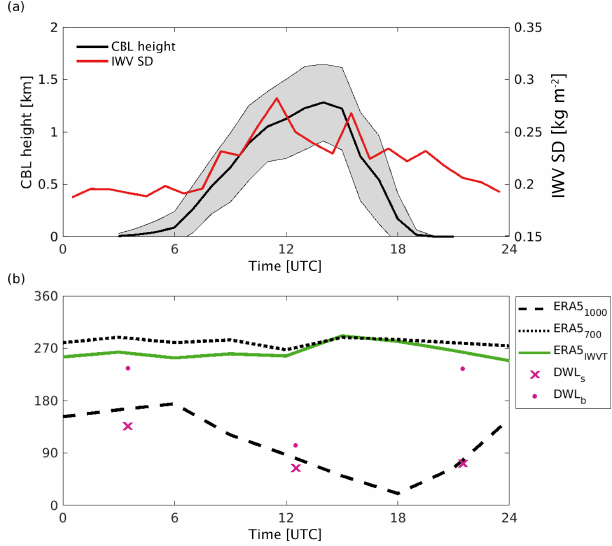
Figure 2. (a) Hourly averaged convective boundary-layer (CBL) height (with standard deviation in shadings) from the Doppler lidar boundary-layer classification at the MWR scan times. The zenith IWV standard deviation (SD) is determined within 1h around the scans. (b) The lines show the directions (in degree) of the av- eraged ERA5 wind directions at 1000hPa (ERA5 1000 ), 700hPa (ERA5 700 ), and the IWV transport (ERA5 IWVT ). Symbols indicate the mean Doppler lidar wind direction (average times: 01:00–06:00, 10:00–15:00, and 19:00–24:00UTC) at 105m (DWL s ) and 1005m (DWL b